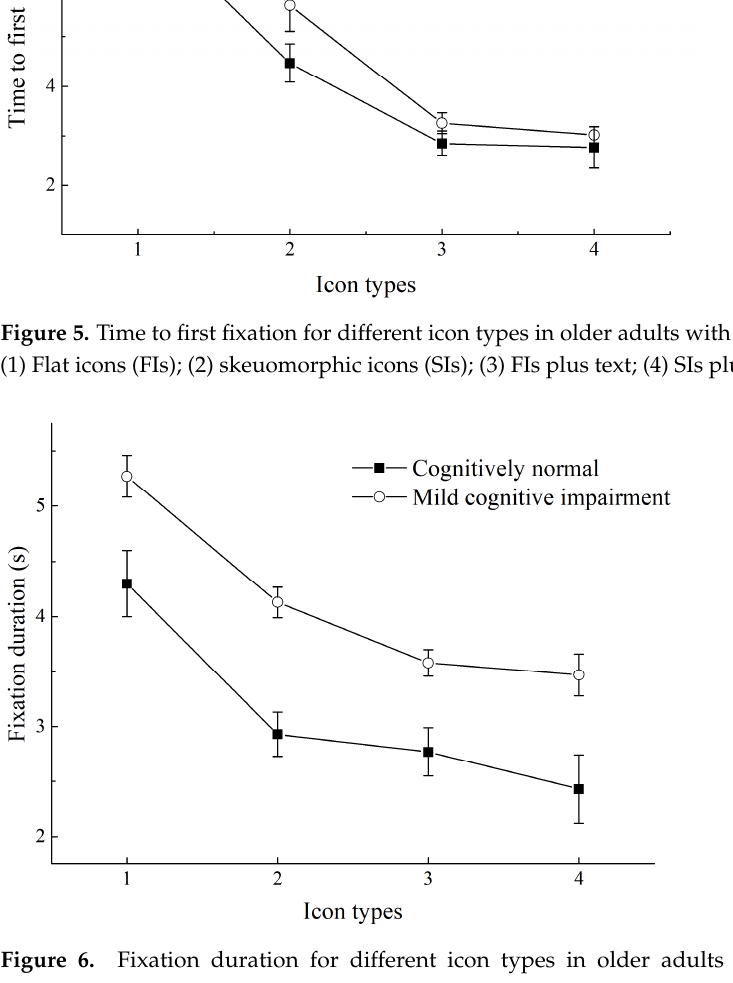
Figure 6. Fixation duration for different icon types in older adults with different cognitive levels. (1) Flat icons (FIs); (2) skeuomorphic icons (SIs); (3) FIs plus text; (4) SIs plus